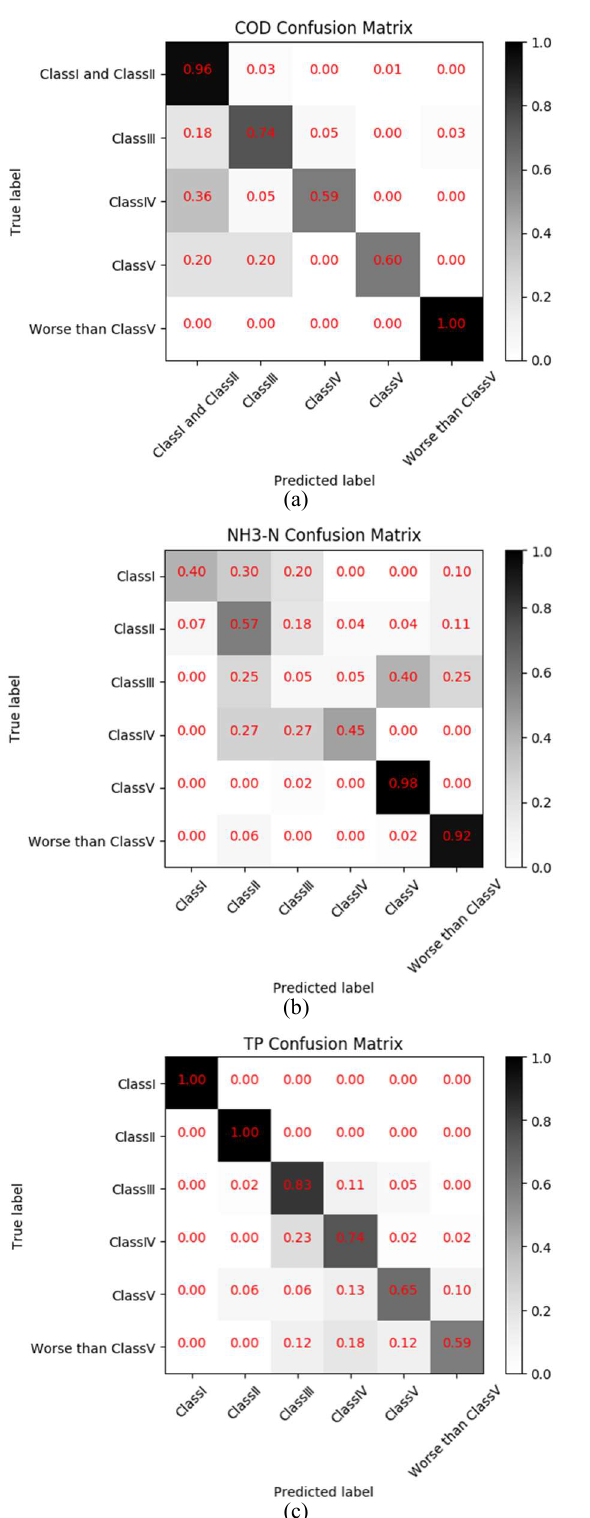
Figure 4. Confusion Matrices of water quality SVM classification